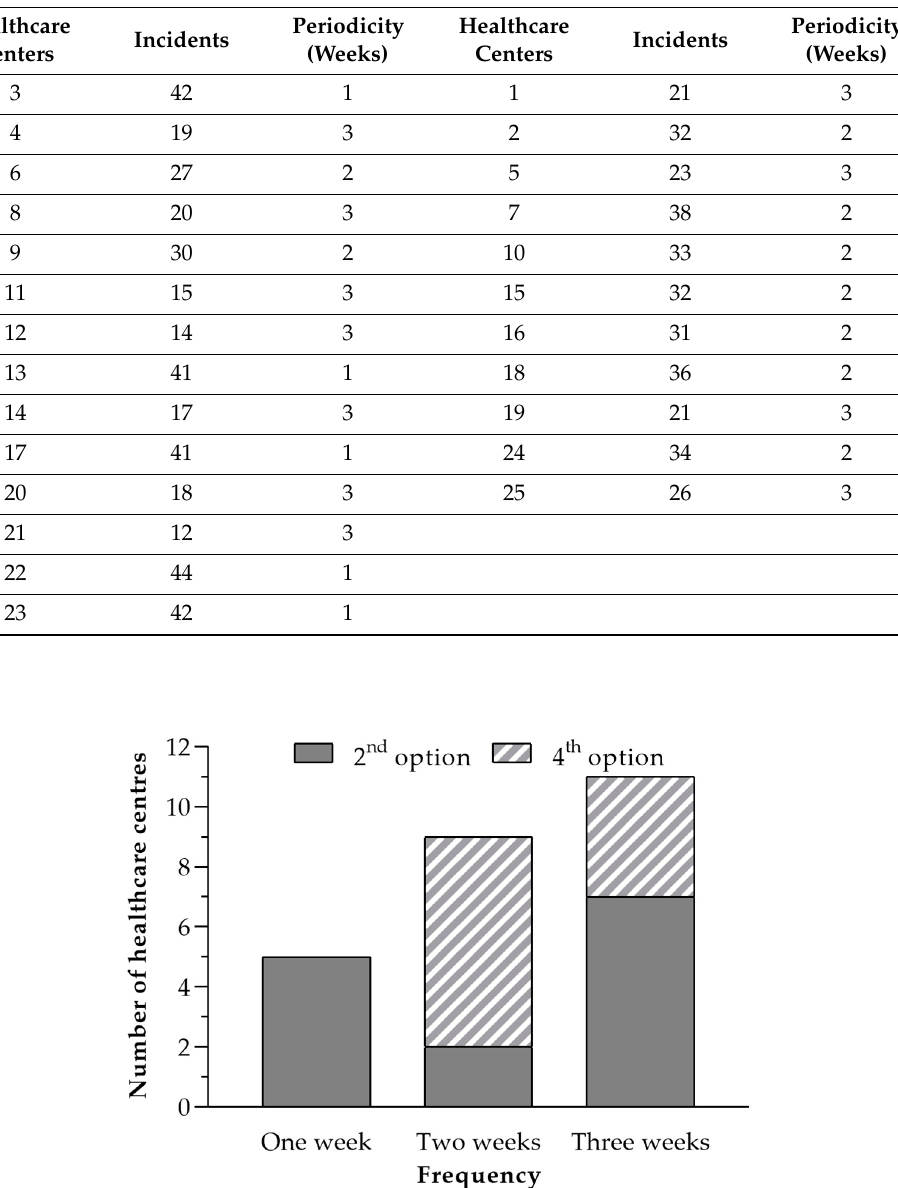
Table 5. Classification of healthcare centers.